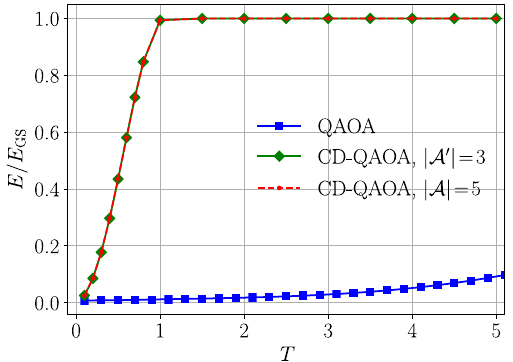
FIG. 5. LMG model: energy minimization against protocol duration T using conventional QAOA (blue square) and CD- QAOA (red dashed line, green solid line). We start from the z - polarized state j ψ i i ¼ j ↓↓ (cid:4) (cid:4) (cid:4)i and target the ground state of LMG Hamiltonian (5). CD-QAOA significantly outperforms conventional QAOA for short durations. The alternating unitaries H ; H for conventional QAOA are generated by A 1 2 g QAOA ¼ f [cf. Eq. (5)]; for CD-QAOA, we extend this set using adiabatic H ; H ; Y; ˆ XY; ˆ YZ g and gauge potential terms to A 1 2 CD − QAOA ¼ f A 0 H ; H ; Y g . The external field is h=J ¼ 0 . 5 , the 1 2 CD − QAOA ¼ f circuit depth is q ¼ 8 , and the system size is N ¼ 501 , where the effective Hilbert dimension dim ð H Þ ¼ 502